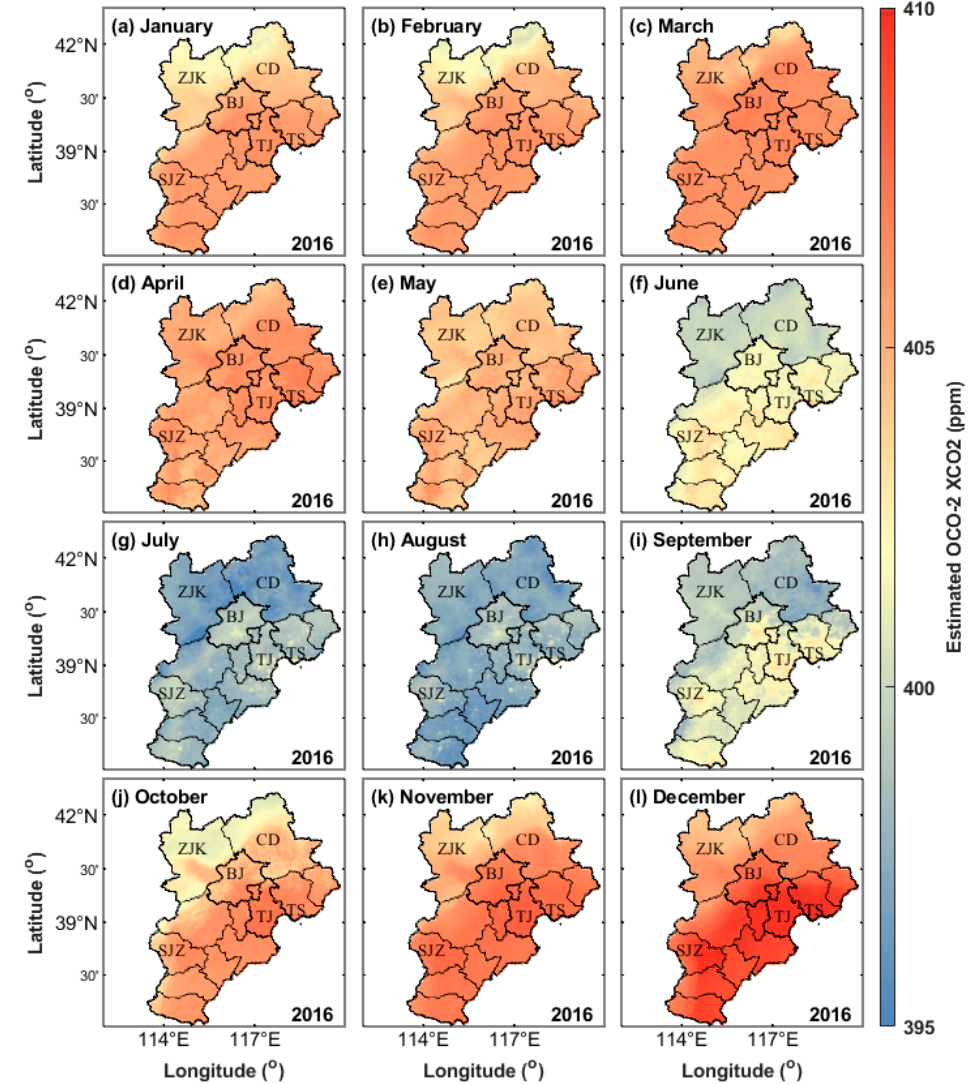
Figure 11. Monthly average XCO 2 concentrations in the Beijing–Tianjin–Hebei region from January 2016 to December 2016. ZJK, CD, BJ, TJ, TS, and SJZ represent Zhangjiakou, Chengde, Beijing, Tianjin, Tangshan, and Shijiazhuang, respectively. ( a – l ) represent January to December respectively.